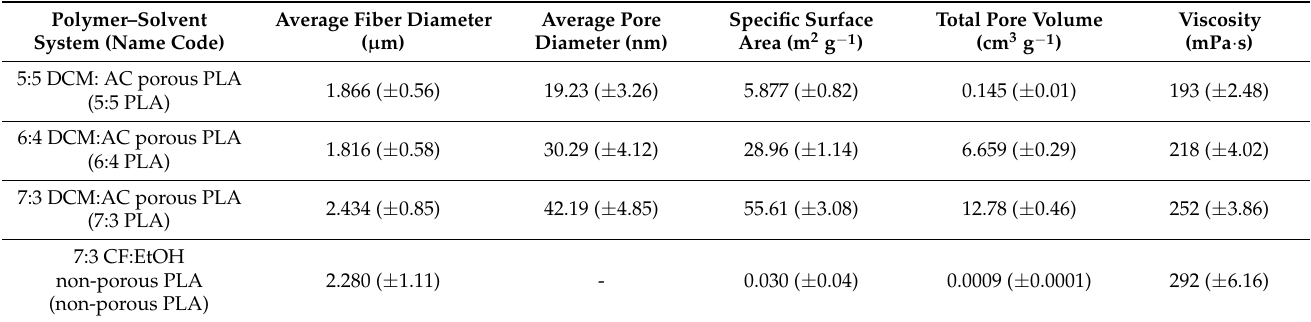
Table 1. Physical properties of electrospun non-porous and porous PLA